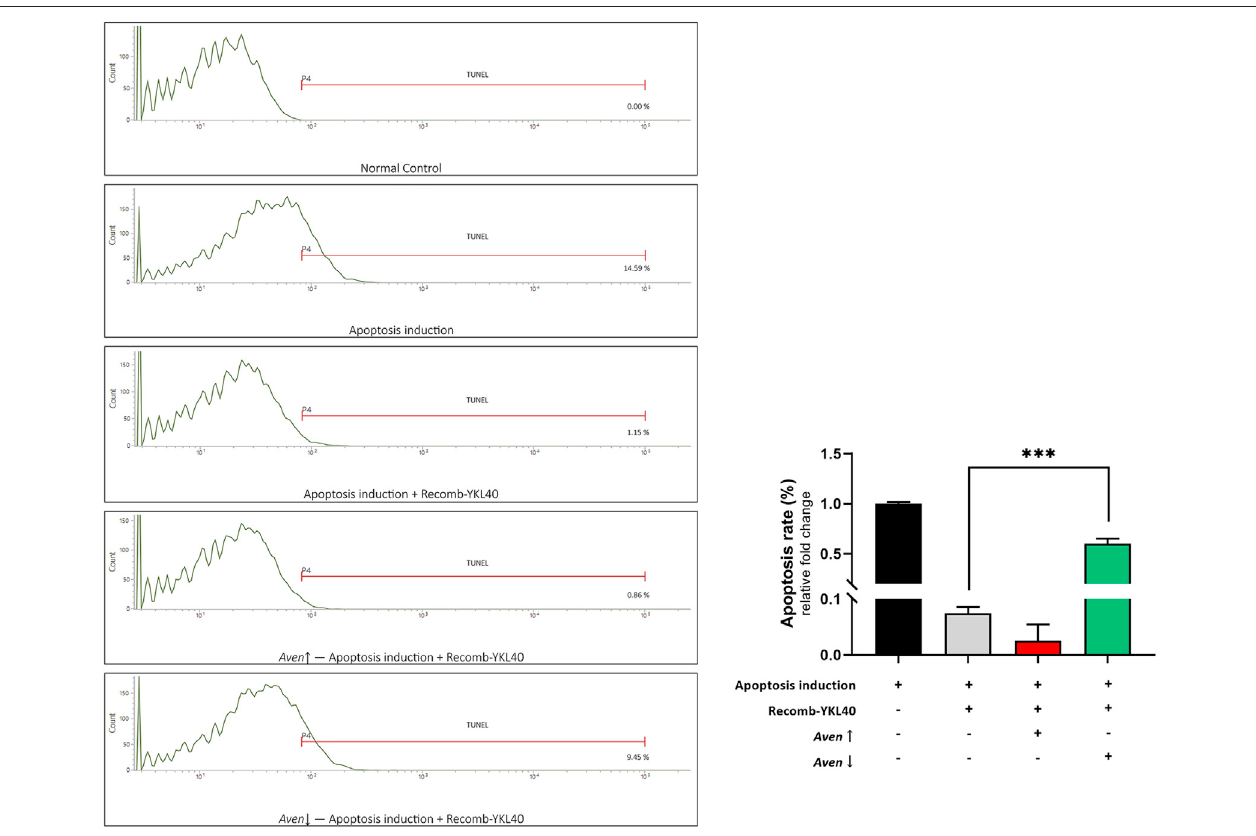
FIGURE 7 | FCM analysisof the apoptosis rate of RAW264.7 after TUNEL staining. Groups are presented as normal controls, the apoptosis model that treated by Ox-LDL accompanied by staurosporine, apoptosis induced combined with YKL-40 treatment, apoptosis induced combined with YKL-40 treatment and Aven ↑ , as well as apoptosis induced combined with YKL-40 treatment and Aven ↓ . The apoptosis rate of RAW264.7 in the recomb-YKL-40 treated group was certainly signi fi cantly lower than that in the apoptosis model group ( p < 0.001); the apoptosis rate of RAW264.7 was signi fi cantly higher in Aven ↓ group than that in Recomb-YKL40 group ( p <